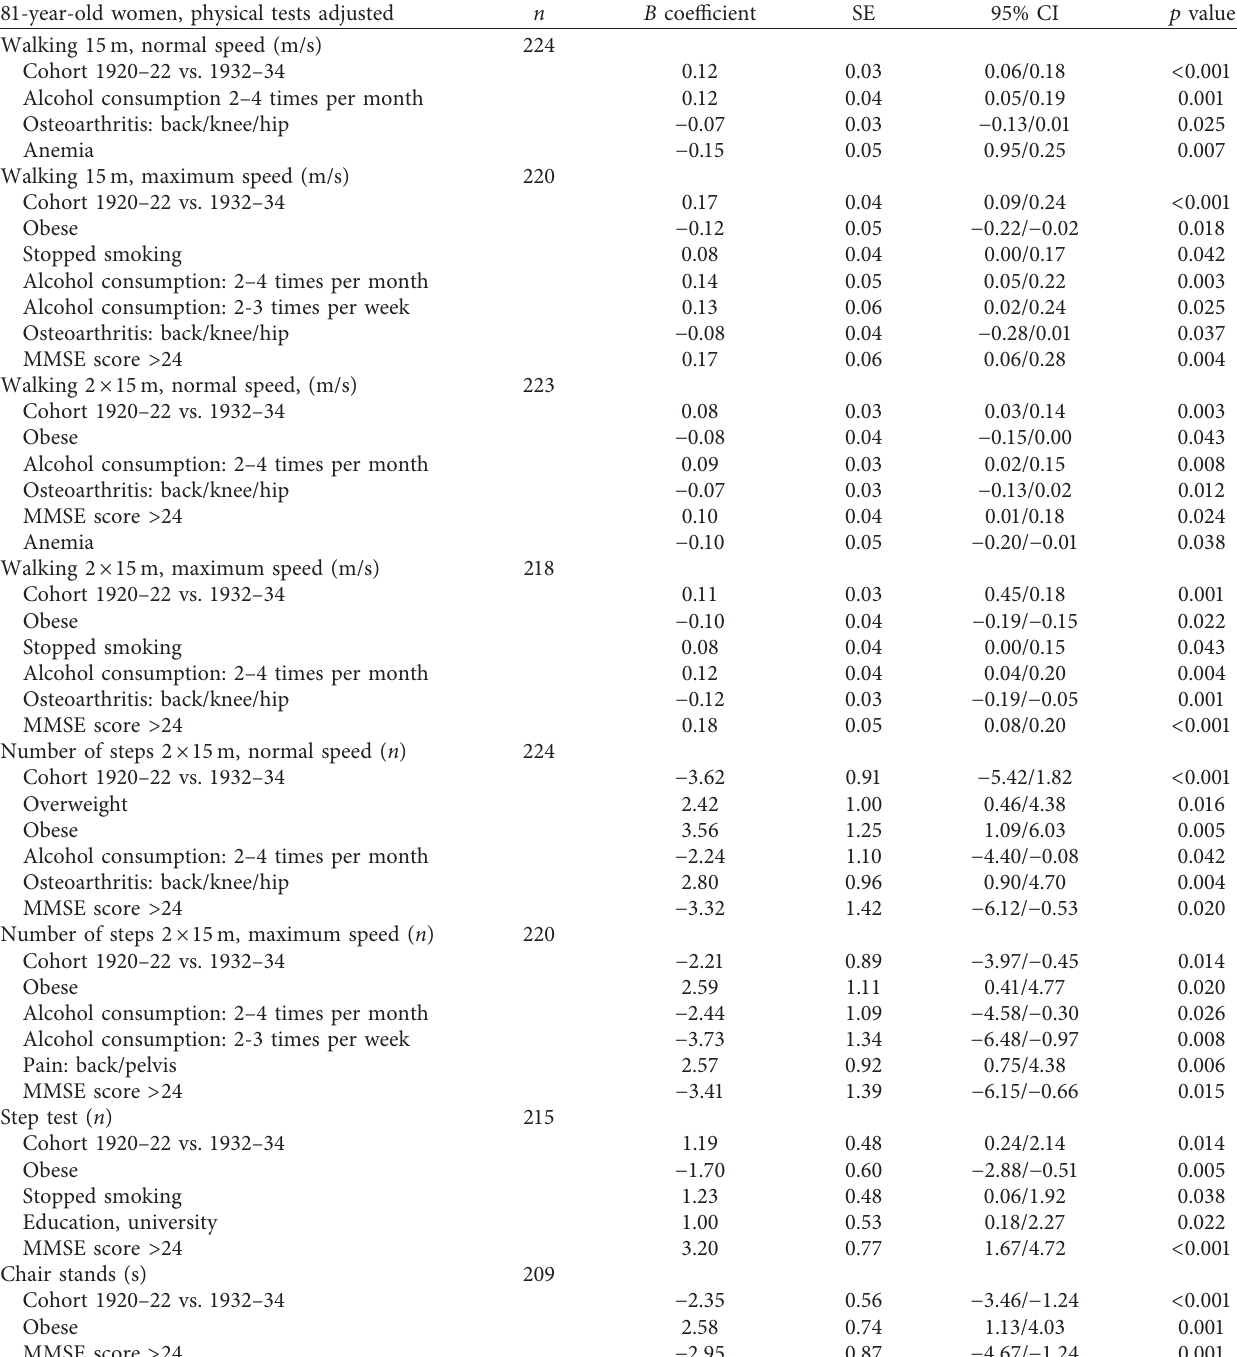
Table 5: Adjusted linear regression models for 81-year-old women with results of physical tests as the dependent variables and birth cohort as the independent